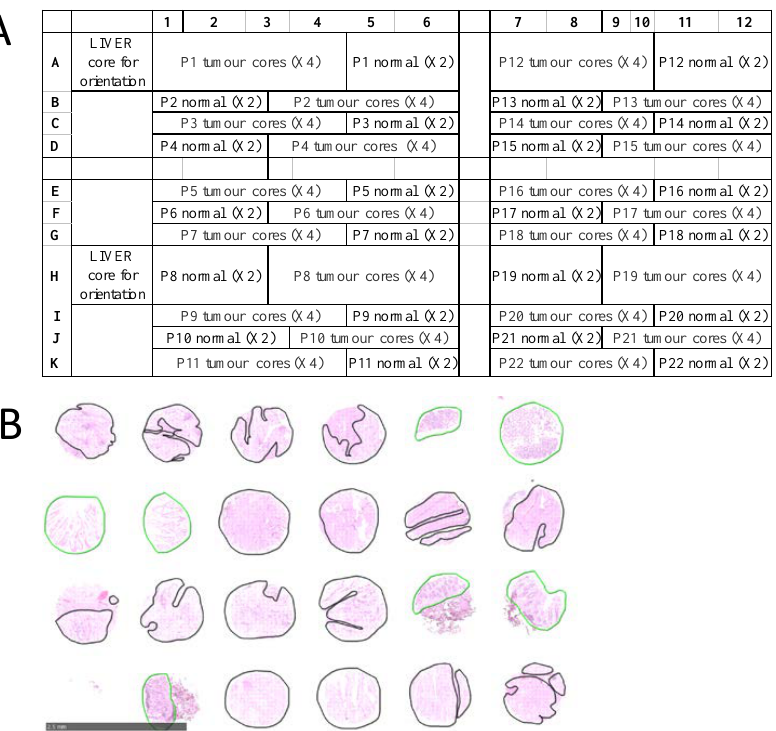
Figure 1. Example CRC TMA. ( A ) TMA layout, each patient has six tissue cores (two ‘normal’ and four ‘tumour’). For example, the cores for patient 1 are placed in Row A, columns 1 to 6. ( B ) Representative zoomed in annotated CRC TMA cores post MALDI MSI, with pathologist annotated regions outlined in green (normal tissue) or black (tumour tissue). Scale bar is 2.5 mm.